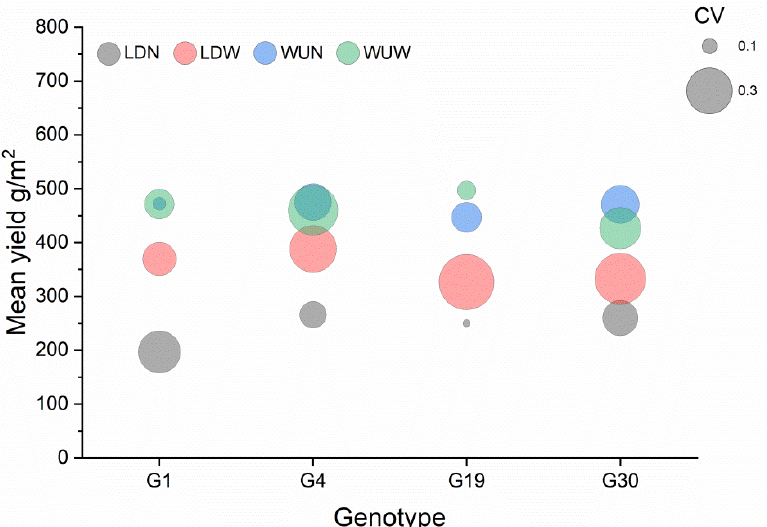
Figure 6. The grain yield and yield stability of four winter wheat cultivars (Guizi 1 (G1), Guizi 4 (G4), Guinong 19 (G19) and Guinong 39 (G30)) under four sowing patterns. A PCA (Figure 7) based on yield formation traits and yield components indicated that the AGB and SN per m 2 highly correlated with PC1 were positively correlated with grain yield. PC2 was correlated with HI and 1000-grain weight, the inherent features of genotype. The scoring data obtained under the BU sowing patterns were closer to the SN, AGB and yield loadings than the LD conditions.